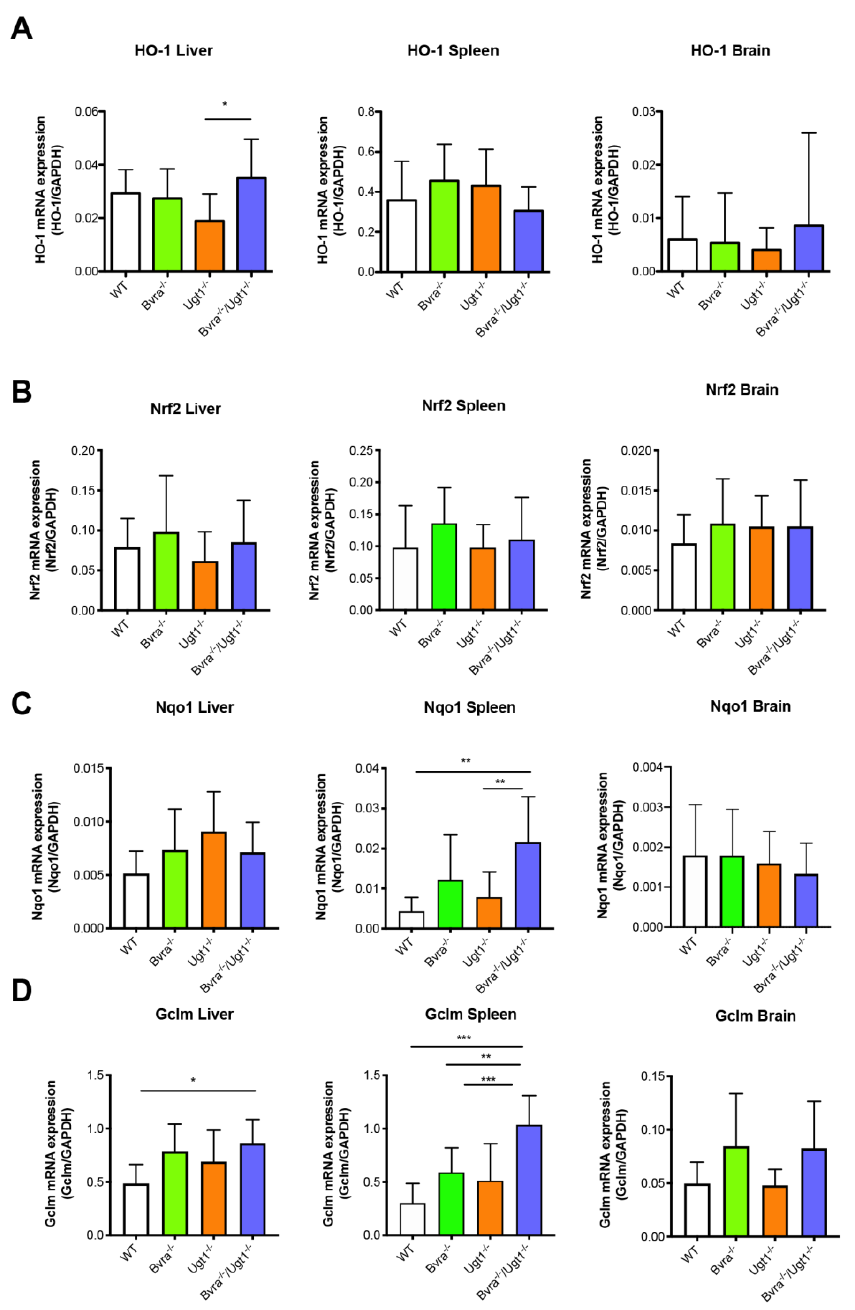
Figure 6. Gene expression analysis of oxidative stress markers. ( A ) Hmox1 (HO-1) mRNA expression levels in liver, spleen, and brain. One-way ANOVA: liver, p = 0.0283, F = 3.390, Bonferroni tests: WT vs. Bvra − / − Ugt1 − / − , ns; spleen: p = 0.1705, F = 1.759, ns; brain, p = 0.8114, F = 0.3193, ns.; ( B ) Nfe2l2 (Nrf2) mRNA expression levels in liver, spleen, and brain. One-way ANOVA, liver: p = 0.3650, F = 1.089, NS; spleen, p = 0.3167, F = 1.215, NS; brain: p = 0.6649, F = 0.5292, NS; ( C ) Nqo1 mRNA expression levels in liver, spleen, and brain. One-way ANOVA, liver: p = 0.1049, F = 2.196, NS; spleen: p = 0.0009, F = 6.757, ***, Bonferroni test: WT vs. Bvra − / − Ugt1 − / − p = 0.0013, **; brain: p = 0.4100, F = 0.9853, NS; ( D ) Gclm mRNA expression levels in liver, spleen, and brain. One-way ANOVA, liver: p = 0.0127, F = 4.085, *, Bonferroni test: WT vs. Bvra − / − Ugt1 − / − p = 0.0121, *; spleen: p < 0.0001, F = 12.57; Bonferroni tests: WT vs. Bvra − / − Ugt1 − / − p < 0.001, ***, Bvra − / − vs. Bvra − / − Ugt1 − / − p = 0.0034, **, Ugt1 −/− vs. Bvra −/− Ugt1 −/− p = 0.0003, ***; brain: p = 0.0217, F = 3.612, *, Bonferroni tests: NS. Data represent the mean ± SD.